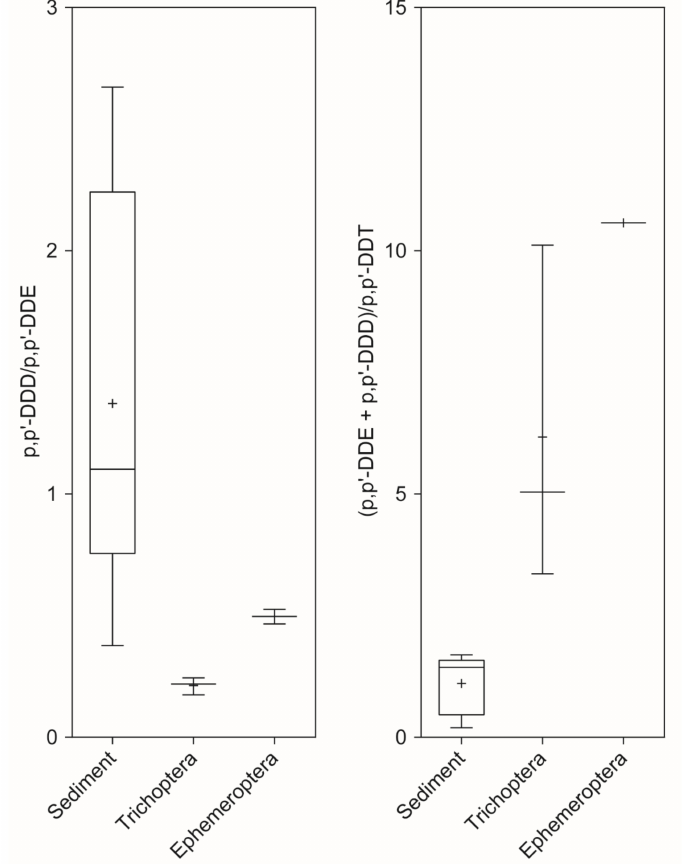
Figure 4. The p,p’-DDD/p,p’-DDE and (p,p’-DDE + p,p’-DDD)/p,p’-DDT ratio between sample